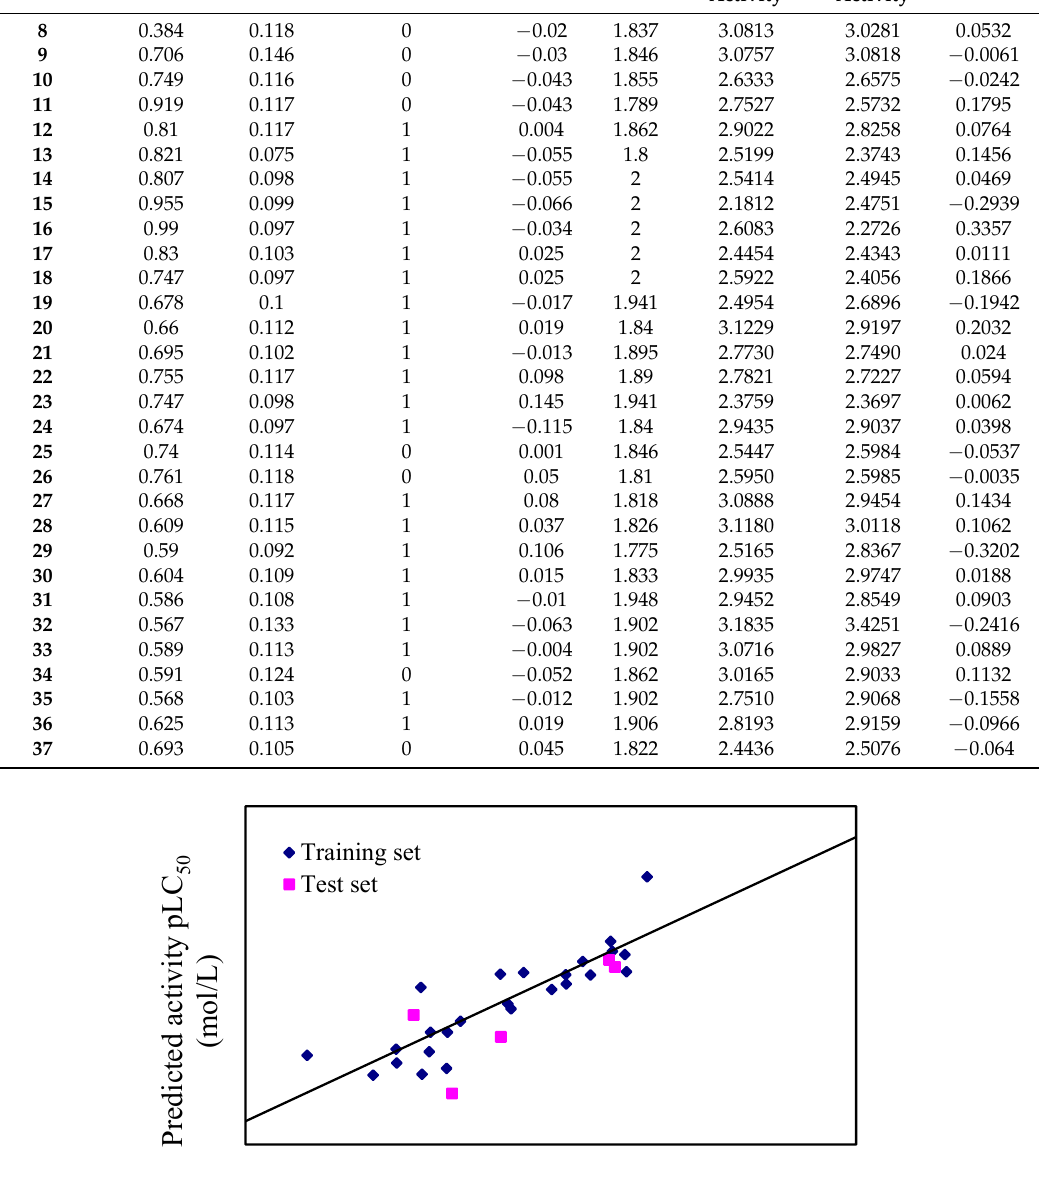
Figure 1. Plot of experimental versus predicted pLC 50 (mol/L) values of training sets and test sets against female T. cinnabarinus .